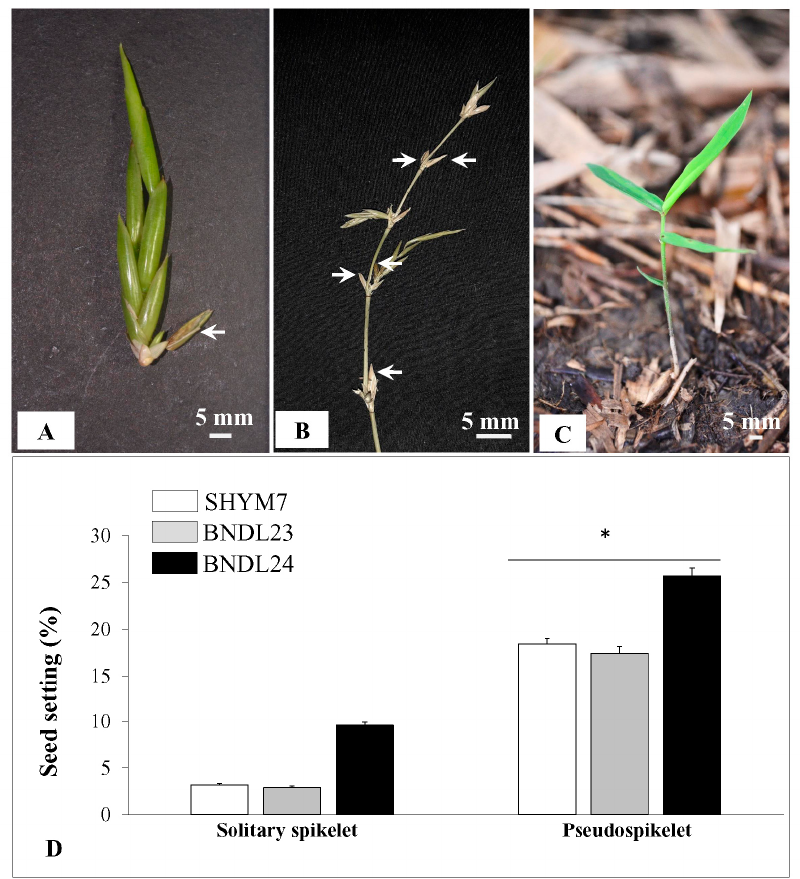
Figure 8. Studies on the rate of seed setting between solitary spikelets and pseudospikelets. ( A ) Soli- tary spikelet inflorescence with single seed-bearing floret. ( B ) Pseudospikelet inflorescence with multiple seed-bearing florets. Seeds are marked by an arrow. ( C ) Newly emerged young seedling. ( D ) Histogram demonstrating differential seed set observed between solitary spikelets vs. pseu- dospikelets. Two-sample two-sided t -test was performed to test statistical significance at p < 0.050. While performing the test of significance, data for pseudospikelets obtained from the three popula- tions were pooled and compared to the pooled data obtained for solitary